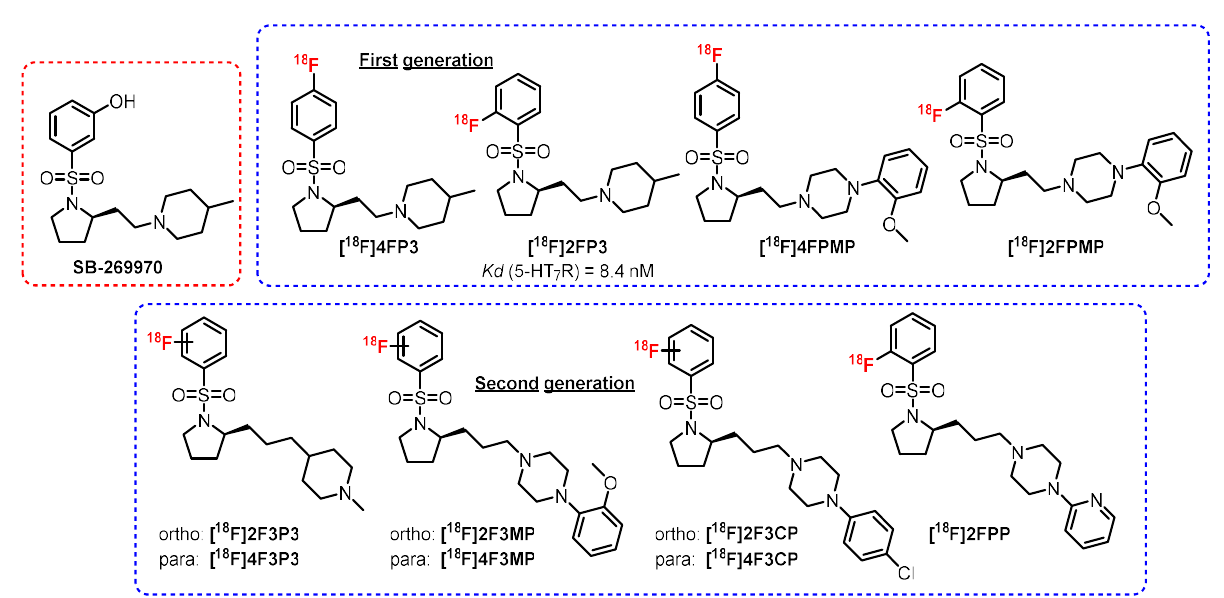
Figure 19. Radiolabeled SB-269970 derivatives.